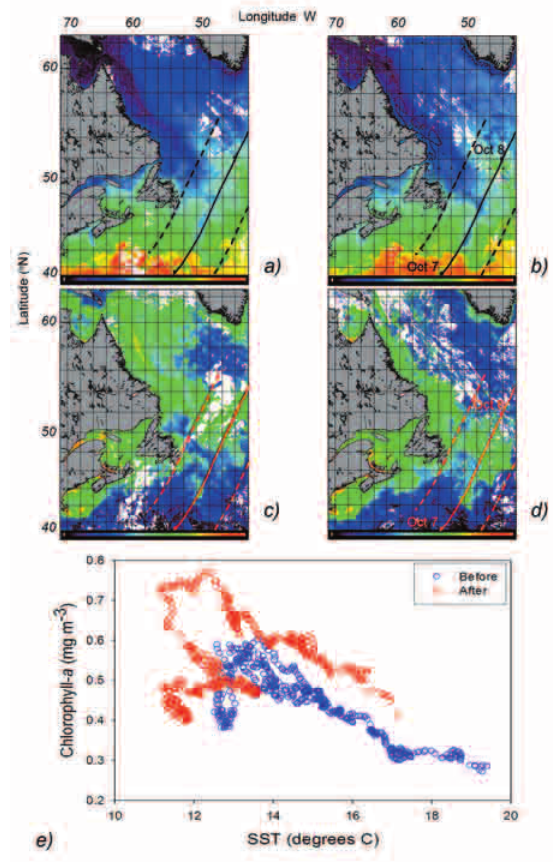
Fig. 12. – Composites of sea surface temperature: a) 12 days before the passage of Hurricane Kate, from September 25 th to October 6 th , and b) 14 days after the passage of the storm, October 7 th to 20 th , 2003. Composites of chlorophyll-a concentration: c) 12 days before, and d) 14 days after the hurricane passage. The storm track and a band of 700 km (350 km on both sides) are also indicated. e) Scatter plot of sea surface temperature against chlorophyll-a. The data are extracted from the composite images under the 700 km area, and averaged across the storm